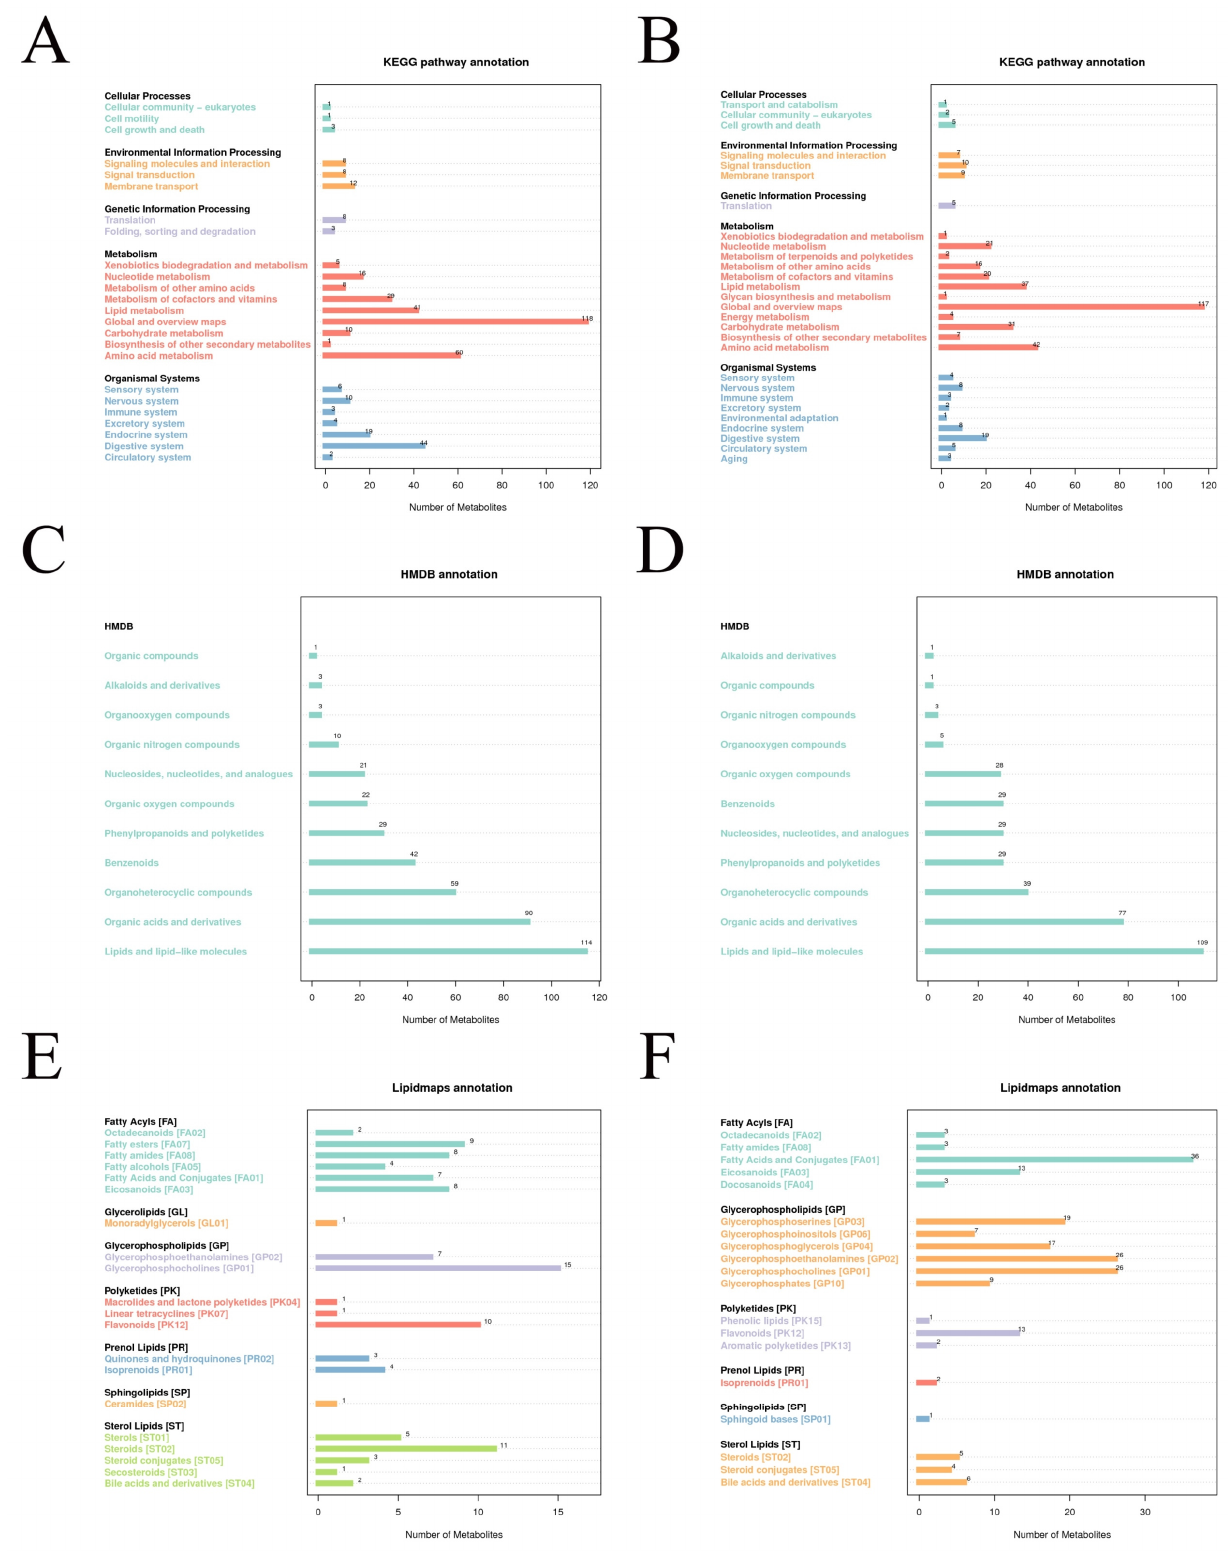
Figure 1. KEGG enrichment results of metabolites identified in positive polarity mode ( A ) and negative polarity mode ( B ). HMDB enrichment results of metabolites identified in positive polarity mode ( C ) and negative polarity mode ( D ). LIPID MAPS enrichment results of metabolites identified in positive polarity mode ( E ) and negative polarity mode ( F